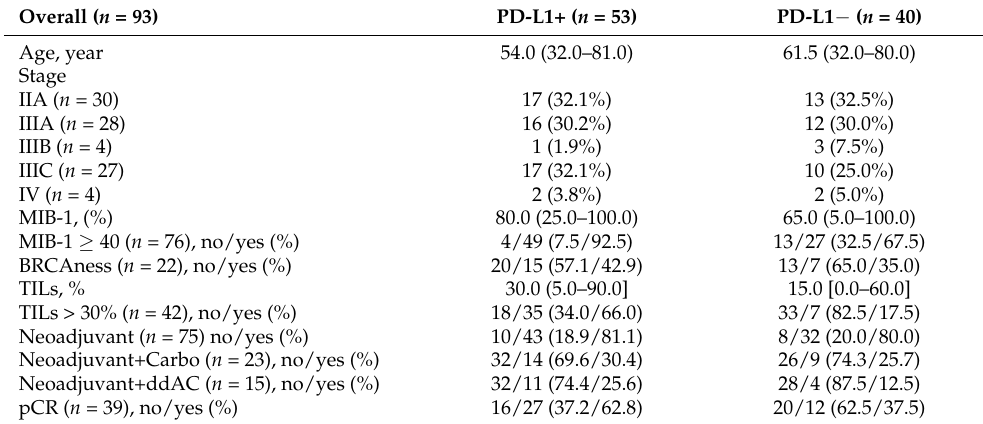
Table 1. Clinicopathological characteristics of